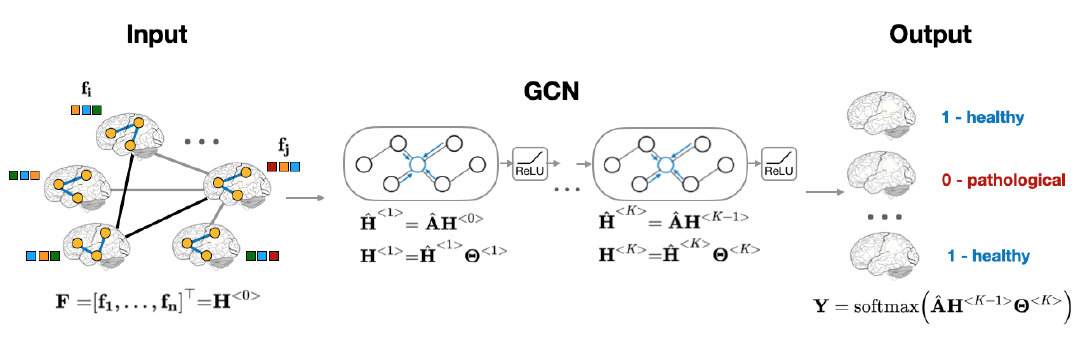
Figure 2. Overview of subject classification using graph neural networks. The model’s inputs are an adjacency matrix representation ˆA of the population graph and a set of subjects’ RSFC features F